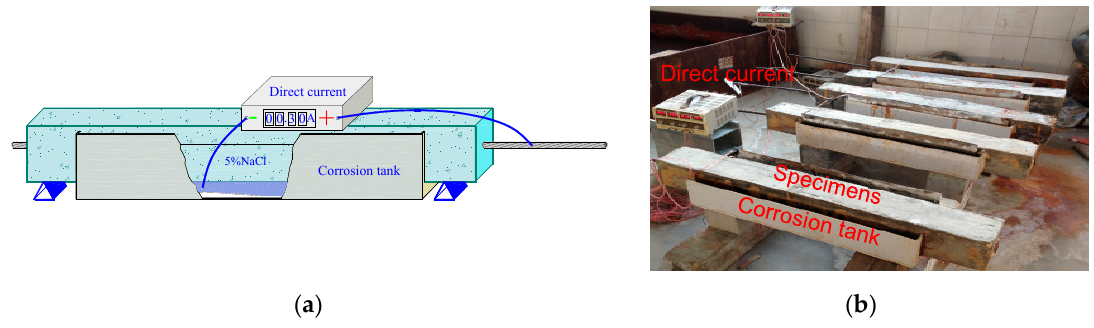
Figure 2. Accelerated corrosion device: ( a ) Schematic diagram; and ( b ) photo.